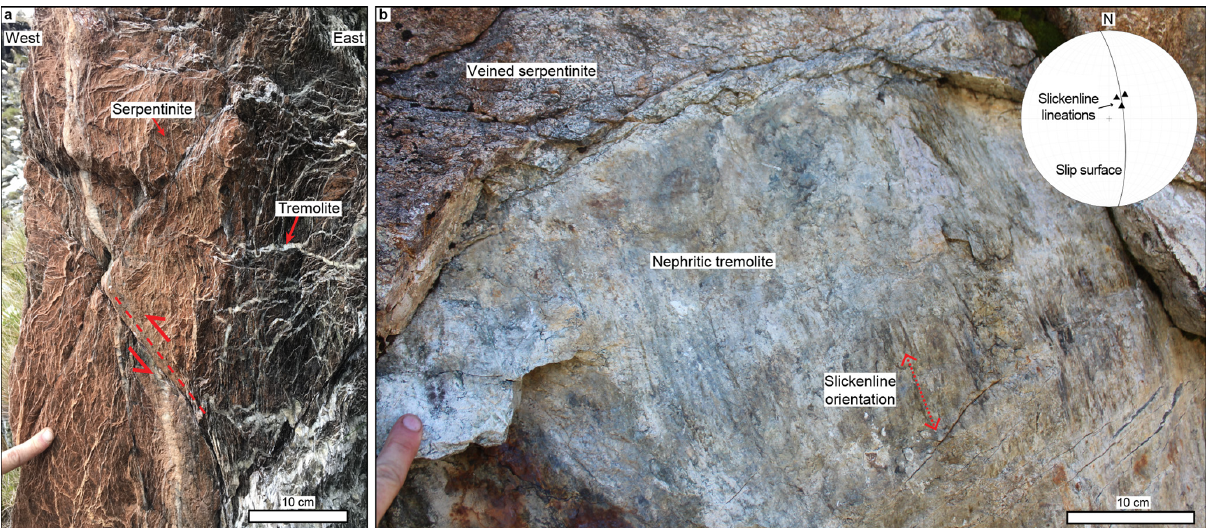
Figure 6. Tremolite vein networks and associated discrete slip surfaces. (a) Multigenerational tremolite vein network at the contact between serpentinite and Caples–Aspiring Terrane schist at Beresford Pass. Cross-cutting fault noted in red. (b) A discrete slip surface cross-cutting the metasomatic reaction zone between serpentinite and Caples–Aspiring Terrane schist at Fiery Col displays steeply plunging slickenlines consistent with overall fault